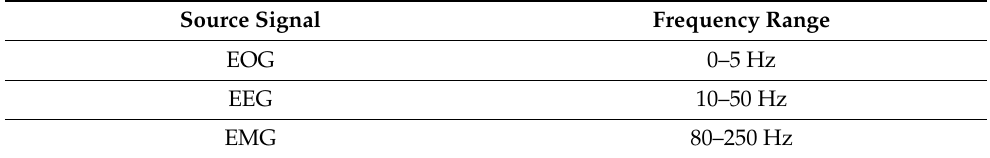
Table 3. Frequency range of each source